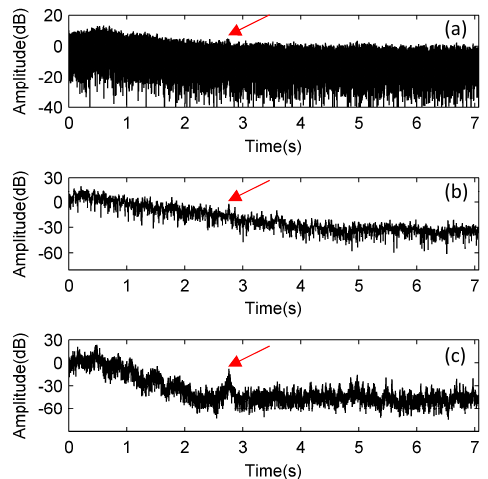
Figure 13. The comparison of the processing results of the received signals from the sea trial: ( a ) Using the MF (SNR = 3 dB); ( b ) Using the FDAMF (SNR = 7 dB); ( c ) Using the TRC-IS-FDAMF (SNR = 16 dB). The arrival time of the target echo is 2.76